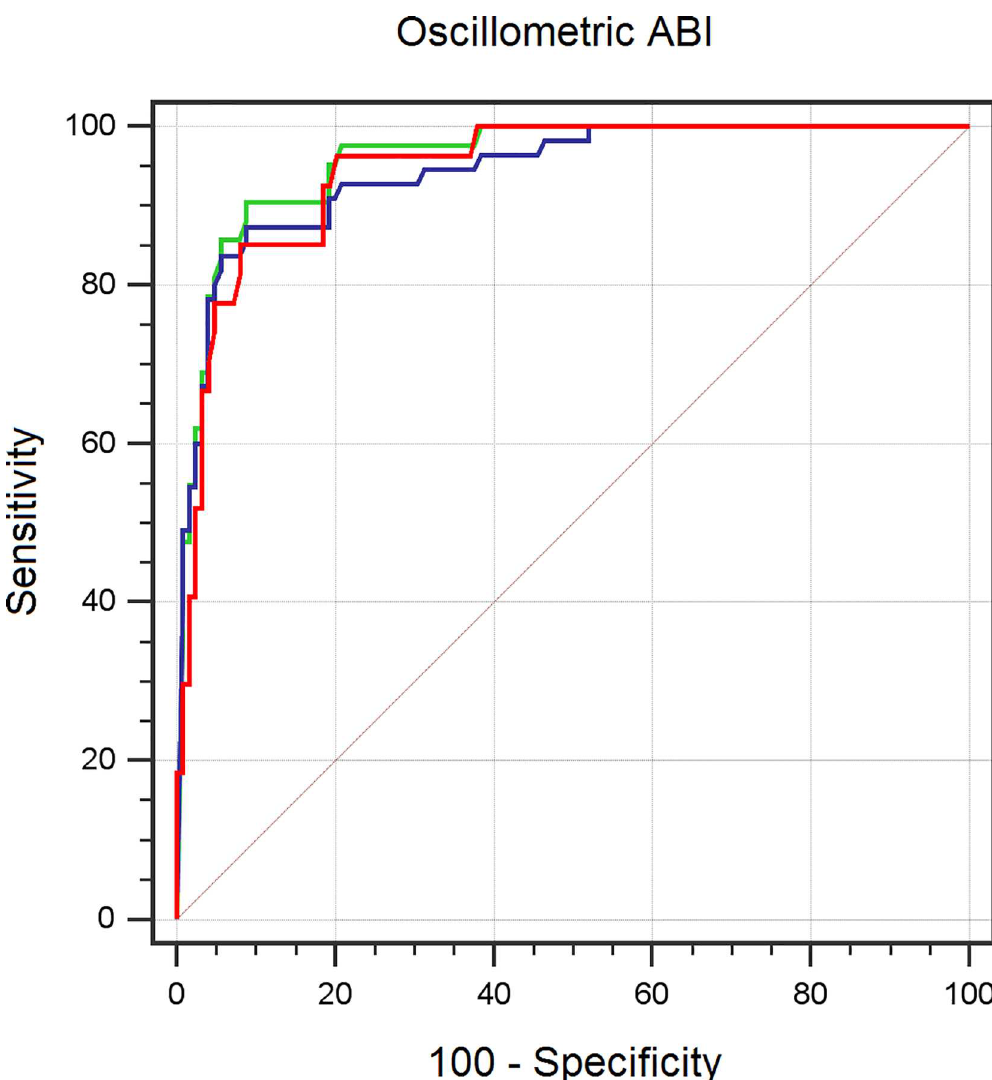
Fig 4. ROC curve for determining PAD by oscillometric ABI compared with Doppler. Blue line: total sample, n = 180. Green line: calcified legs are excluded;oscillometric measurement errors are included, n = 167. Red line: oscillometric measurement errors and calcifiedlegs are excluded,n = 151. The areas under the curve were 0.914, 0.958 and 0.944 respectively,showingthe DeLong´s test no statistically significantdifferencesbetweenthem.